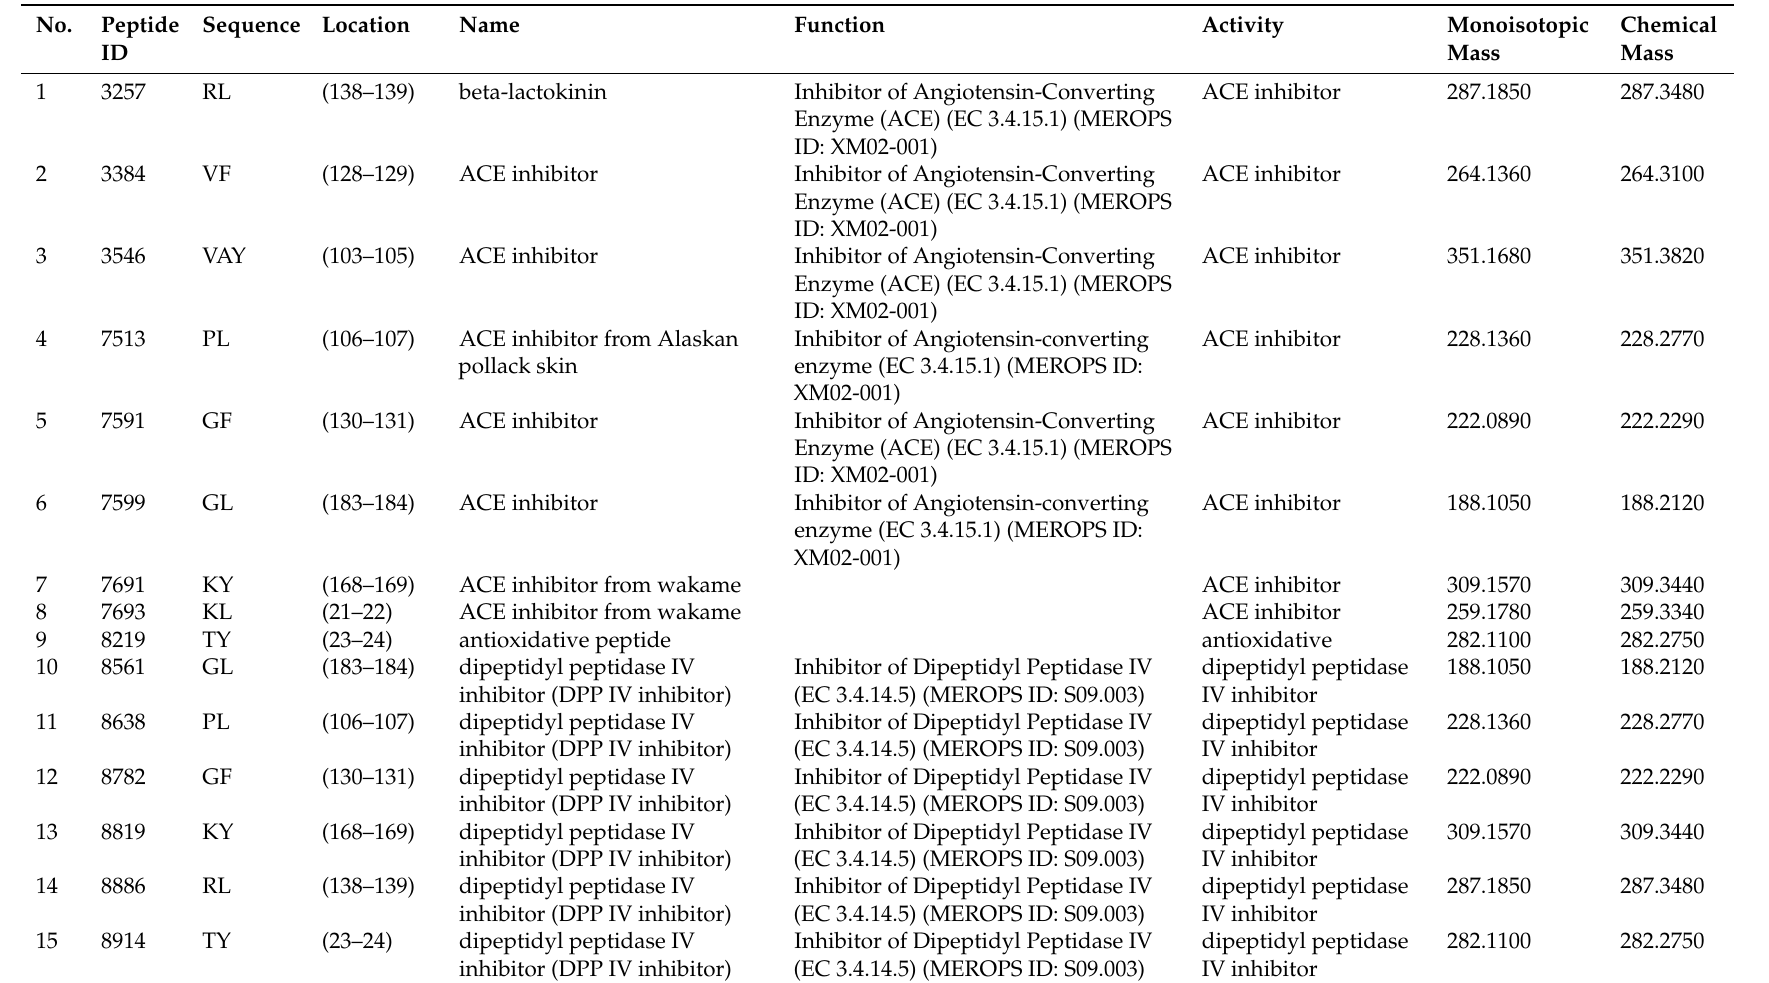
Table A1. Bioactive peptides from RubisCO of Halophila stipulacea . In silico enzymatic cleavage was carried out by using